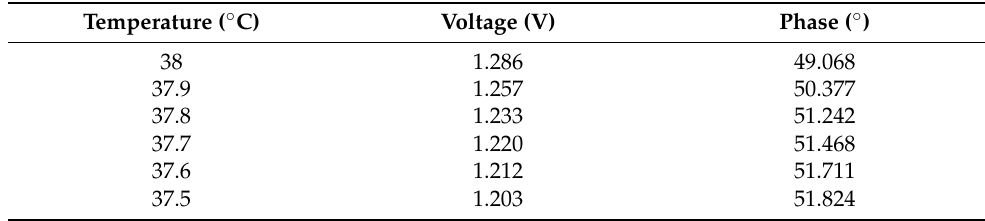
Table 4. Voltage and phase values of some sampled